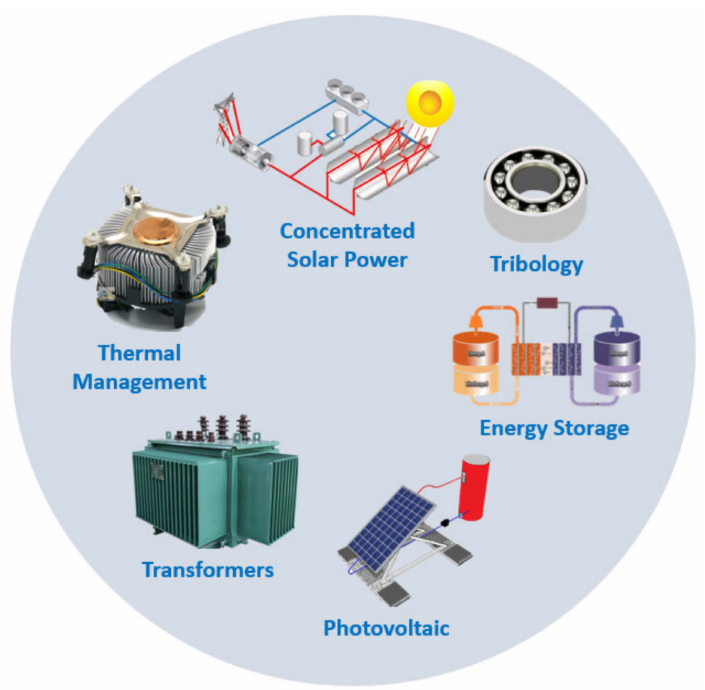
Figure 3. Main practical applications of 2D